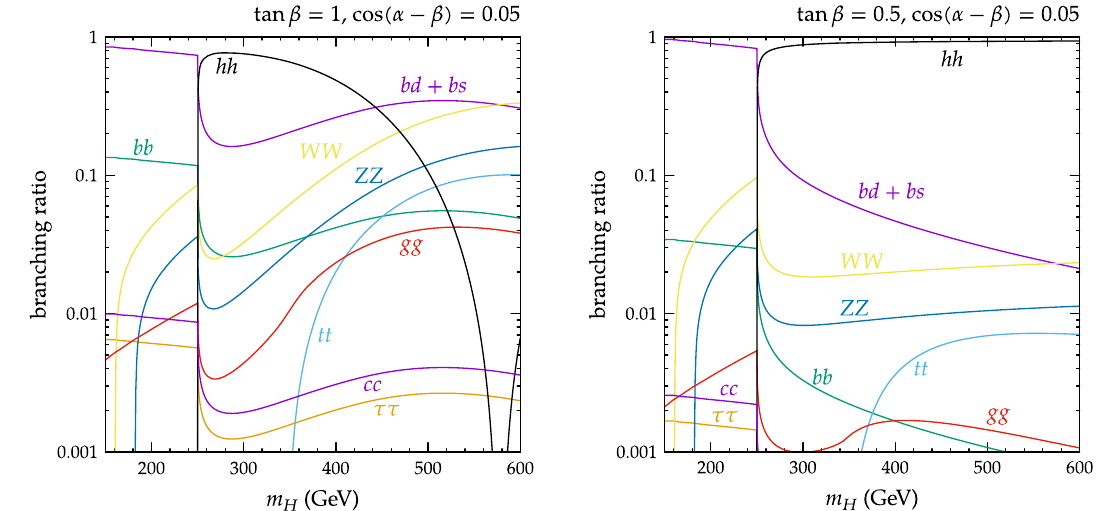
Fig. 9 Branching ratios of the heavy neutral Higgs H . tan β = 1 and μ = 200 GeV (left panel), and tan β = 0 . 5 and μ = 50 GeV (right panel) have been taken. v s = 1 TeV and cos (α − β) = 0 . 05 for both